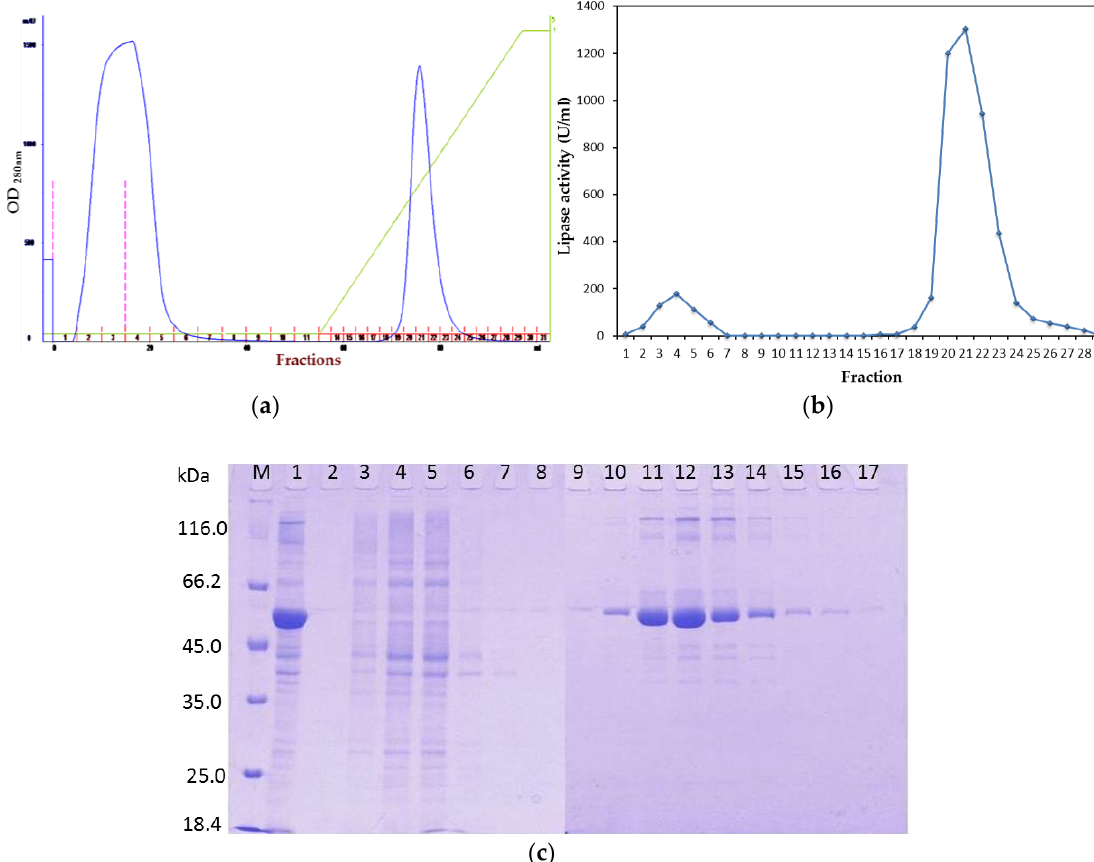
Figure 1. Affinity chromatography of fusion rHZ lipase using Ni Sepharose 6 Fast Flow resin. ( a ) Elution profile of the fusion rHZ lipase. A linear gradient up to 500 mM Imidazole was used. The optical density (OD) at 280 nm was recorded by the AKTA Explorer every 2.56 s. ( b ) Lipase activity profile of the fusion rHZ lipase. The lipase activity was measured at 65 °C for 30 min using olive oil as a substrate. ( c ) SDS-PAGE analysis of the fusion rHZ lipase after affinity chromatography. Lane M: Protein marker, lane 1: crude cell lysate, 2.5 µL sample loaded, lanes 2–4: fractions 1–3 (sample injection), 5 µL sample loaded, lanes 5–8: fractions 4–7 (wash unbound protein) 5 µL sample loaded,